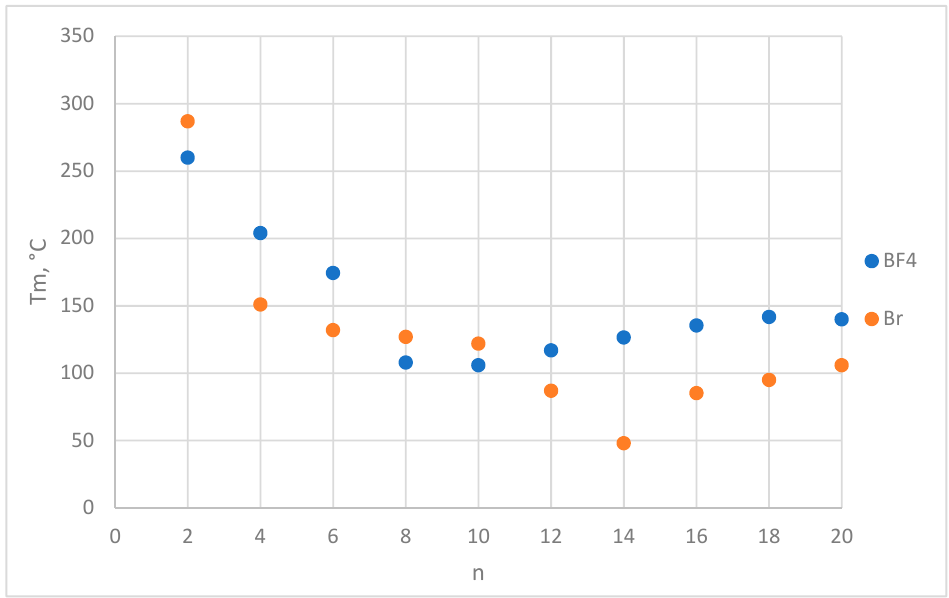
Figure 5. Melting points as a function of the number of carbons, n , in the fourth alkyl substituent on the phosphorus atom.